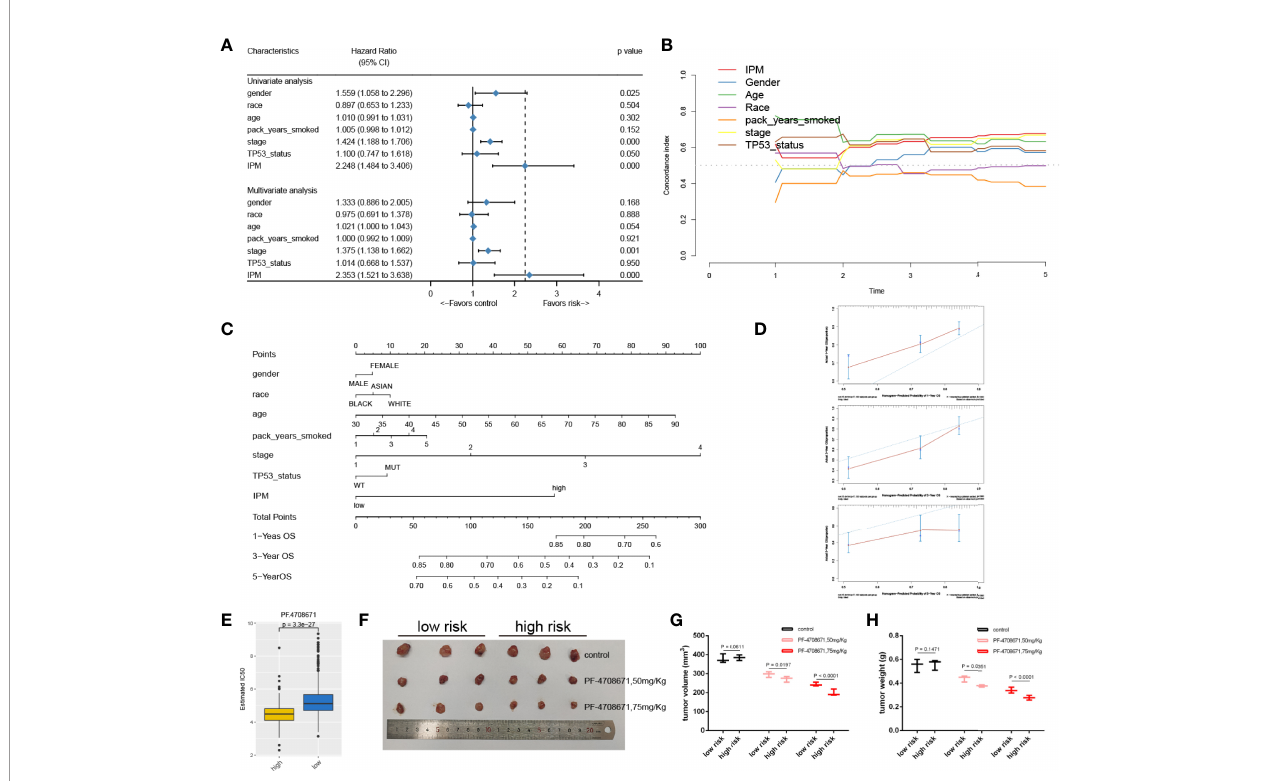
FIGURE 5 | The connection between IPM and conventional clinical characteristics. (A) univariate and multivariate analyses of IPM, TP53 mutation status and clinical features. (B) C-index of IPM, TP53 mutation status, and clinical features. (C) Nomogram for predicting 1-, 3-, and 5-year OS for LUAD patients. (D) Calibration plot of the nomogram for predicting the probability of OS at 1, 3-, and 5-years. (E) IC50 between high and low risk groups. (F) Tumors were harvested and photographed from nude mice. (G) Tumor volume of low- and high-risk groups treated by PF4708671. (H) Tumor weight of low- and high-risk groups treated by